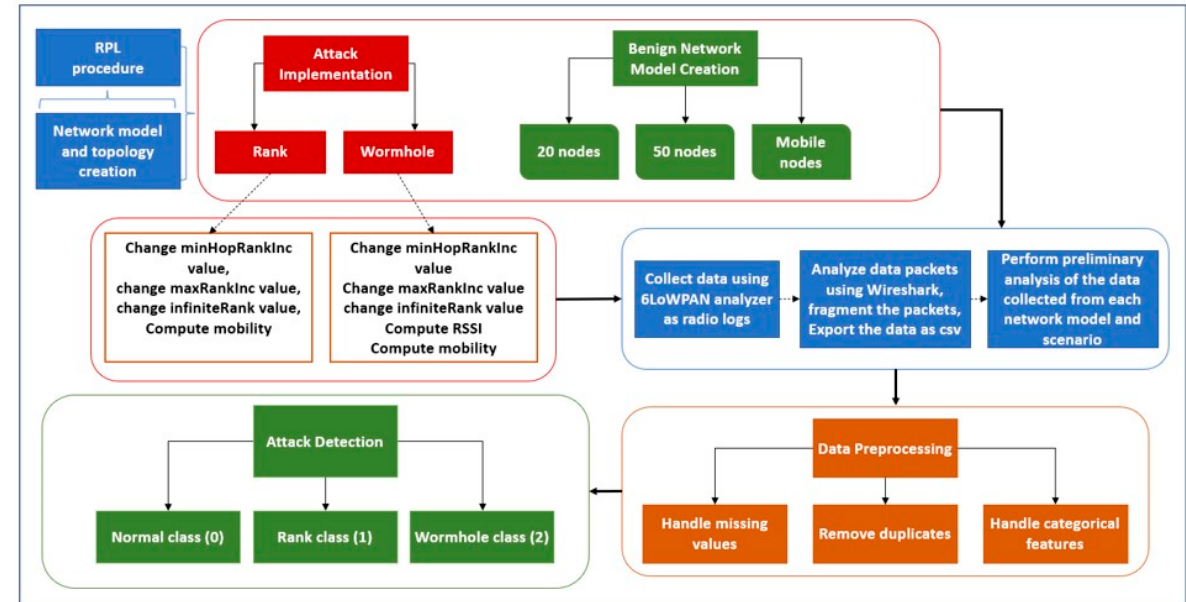
Figure 1. Conceptual design and architecture of the proposed model.